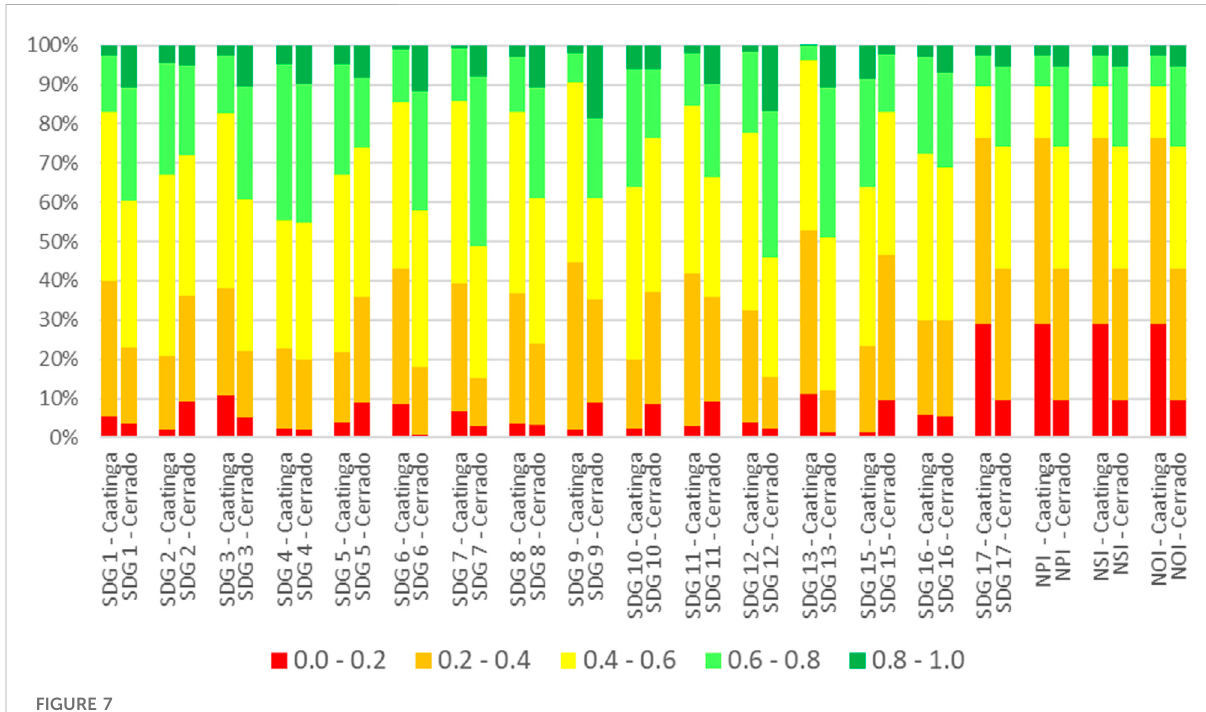
FIGURE 7 Distribution of performance ranges in each of the maps produced by